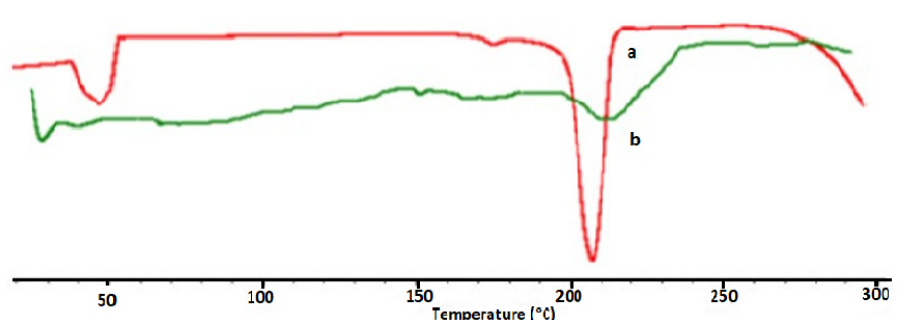
Figure 2. 1 H-NMR spectrum of CC- α -T.